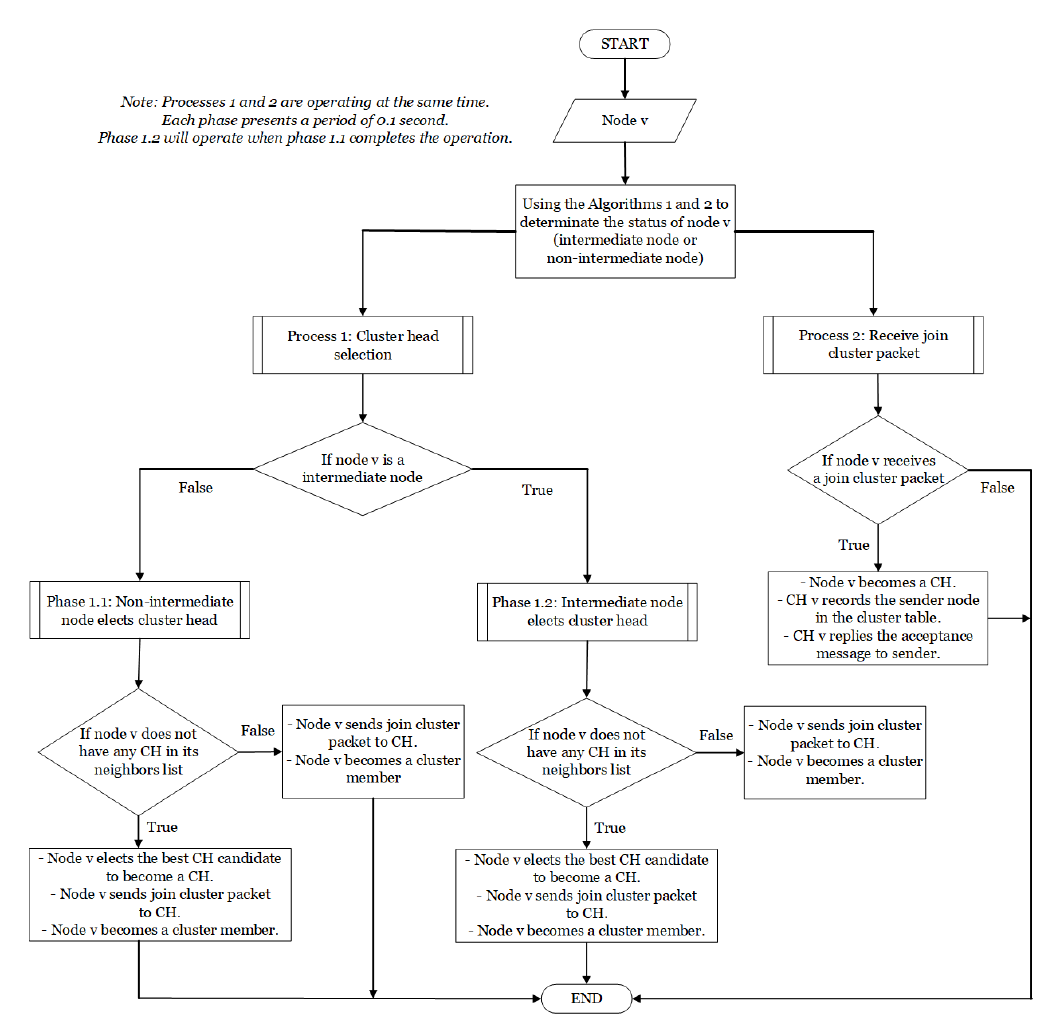
Algorithm 3 The flowchart of proposed connected dominating set based clustering algorithm—CDS based